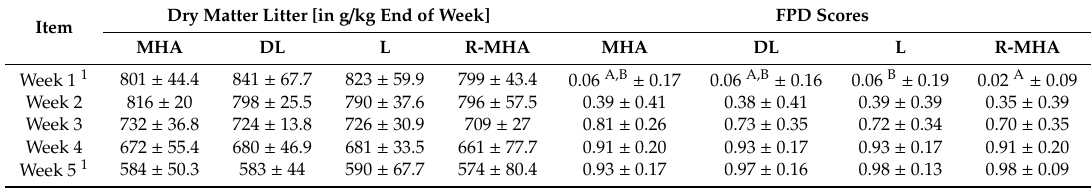
Table 6. DM content of litter material and footpad dermatitis (FPD) scores (mean ± SD).